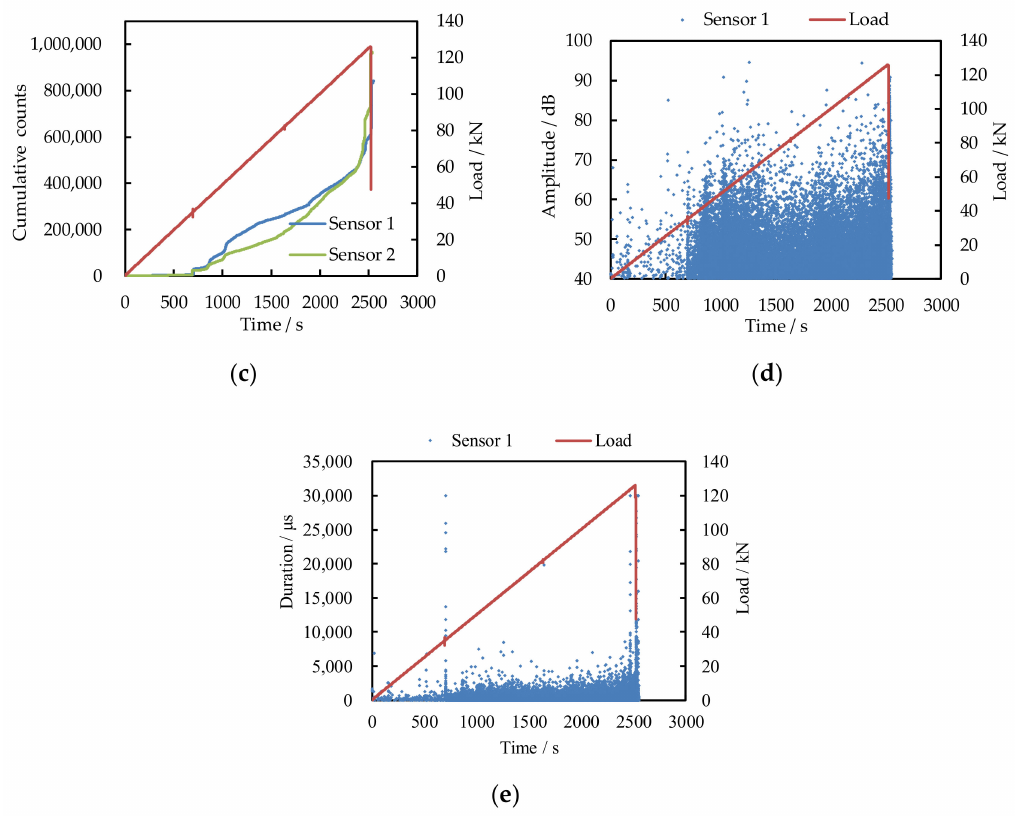
Figure 10. Basic AE parameters of BFRPC beam: ( a ) Cumulative energy; ( b ) Hits; ( c ) Cumulative counts; ( d ) Amplitude; ( e ) Duration.